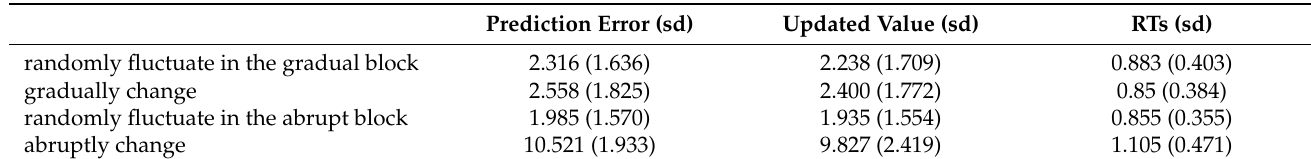
Table 2. Descriptive statistics for variables in the experiment.